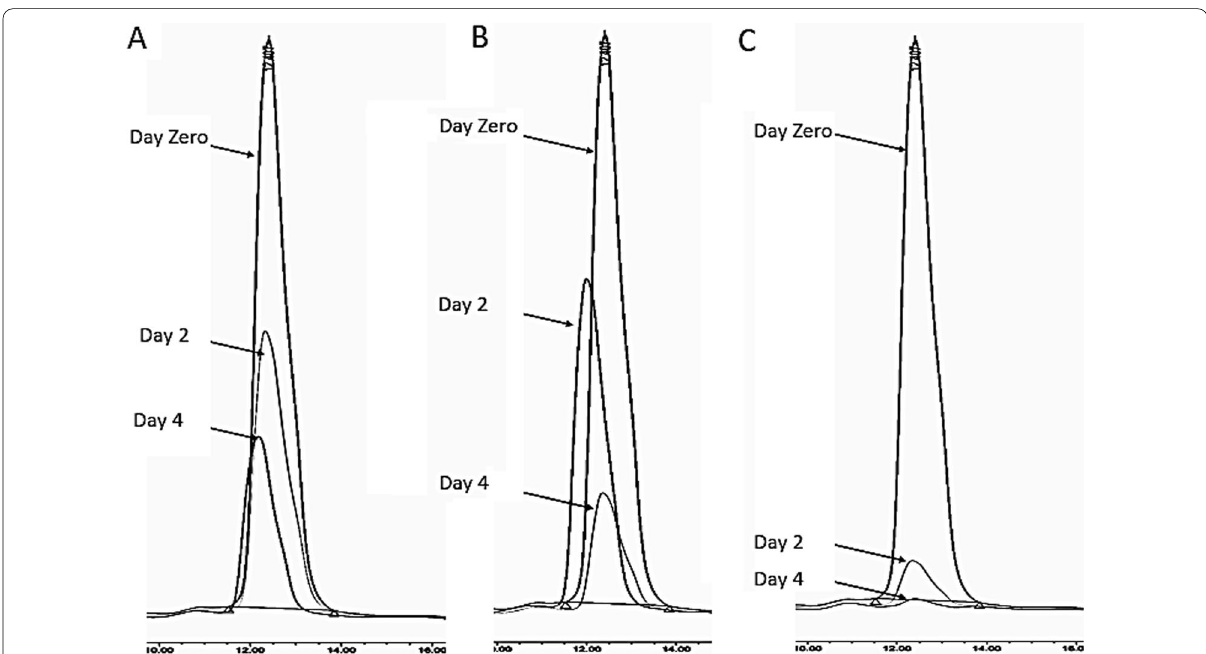
Fig. 3 Anthracene degradation curves at days 0, 2, and 4 for the selected isolates according to the HPLC analysis a Brevibacillus sp., b Pseudomonas sp., and c Methylocystis